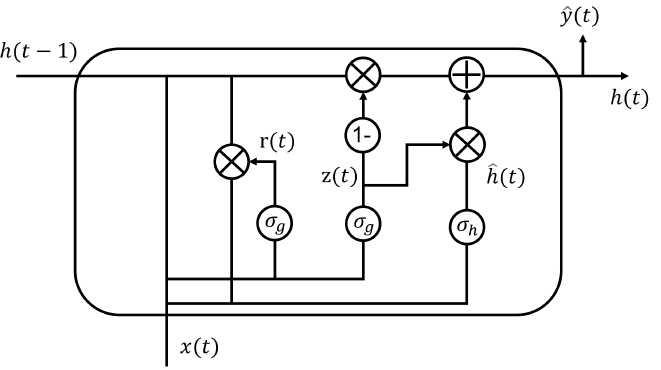
Figure 6. Architecture of the GRU